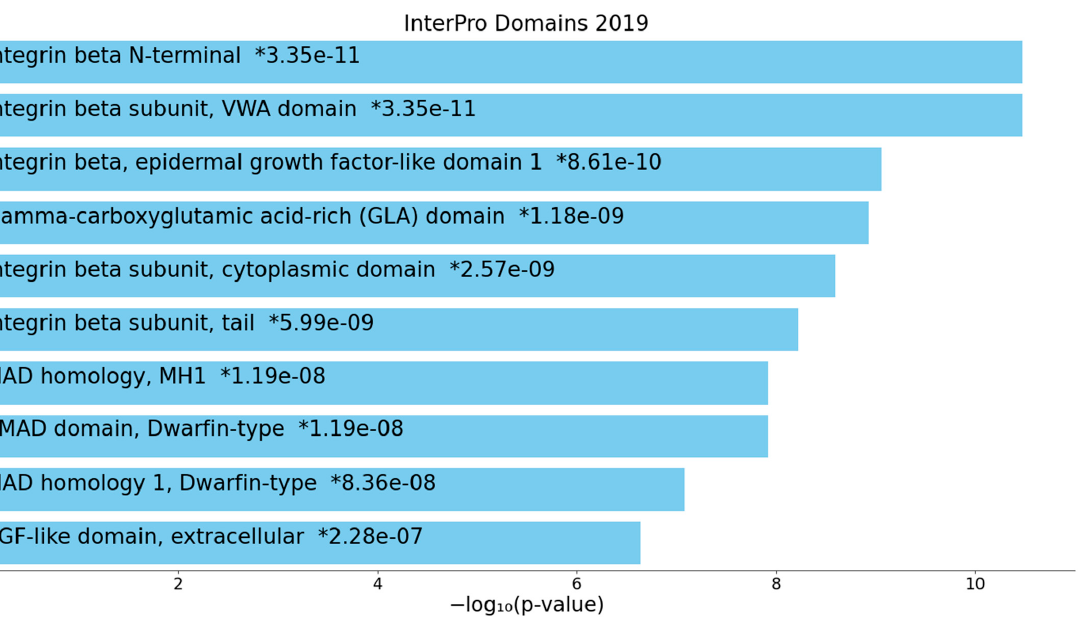
Figure 5. Heatmap of enriched Gene Ontology (GO) molecular functions that were overexpressed in the second protein subnetwork of patients who died due to ischemic stroke (accumulative hypergeometric p -values). I-SMAD: inhibitory SMAD. “Colored bars correspond to terms with significant p -values (<0.05); the * indicate that the term has a significant adjusted p -value (<0.05)” (Appyters, Appyter (maayanlab.cloud) as accessed 6 November 2021).